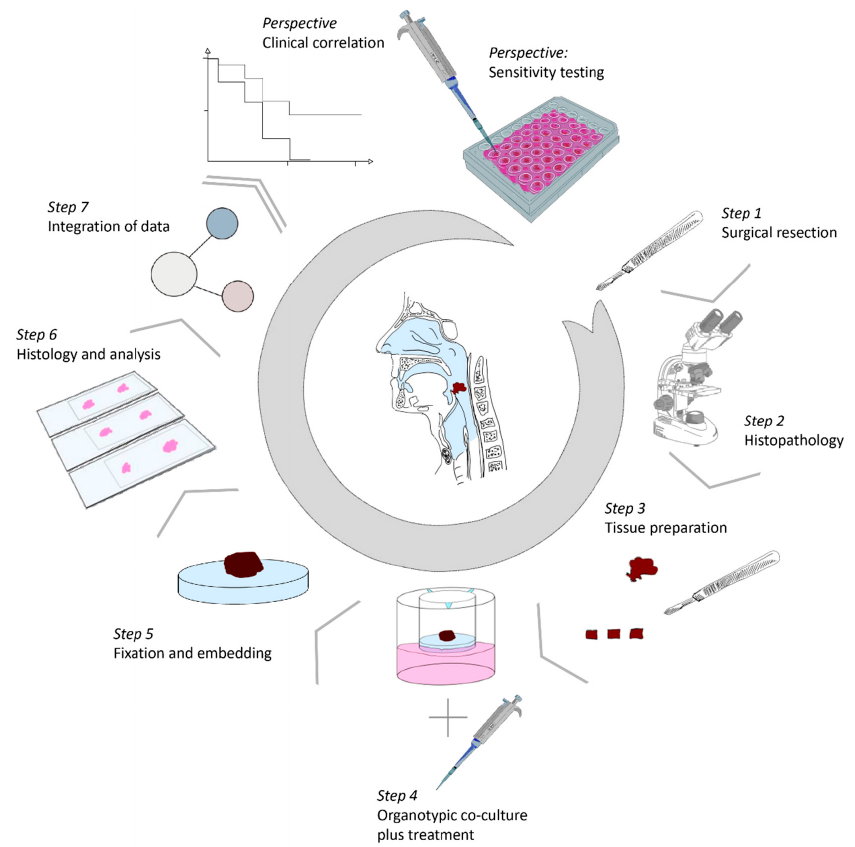
Figure 1. Workflow of the experimental setting. After surgical resection (step 1), vital tumor